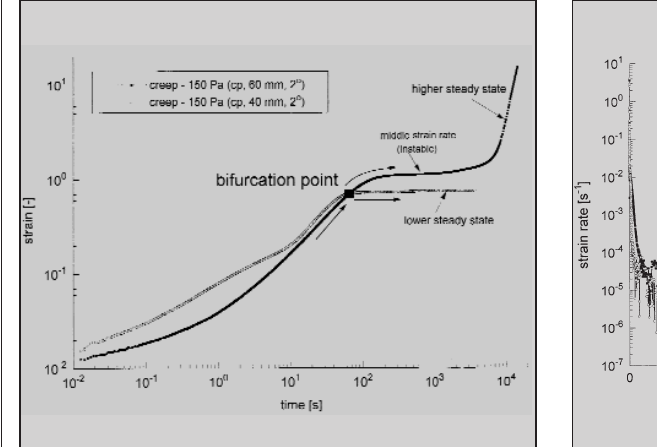
Figure 6 (left): The experimental depend- ence γ (t); lubricating grease at 20 o C, TA con- trolled stress rheometer AR 1000 N(University of Wales at Aberystwyth). Figure 7 (right): The experimental dependence, γ · (t); lubricating grease at 20 o